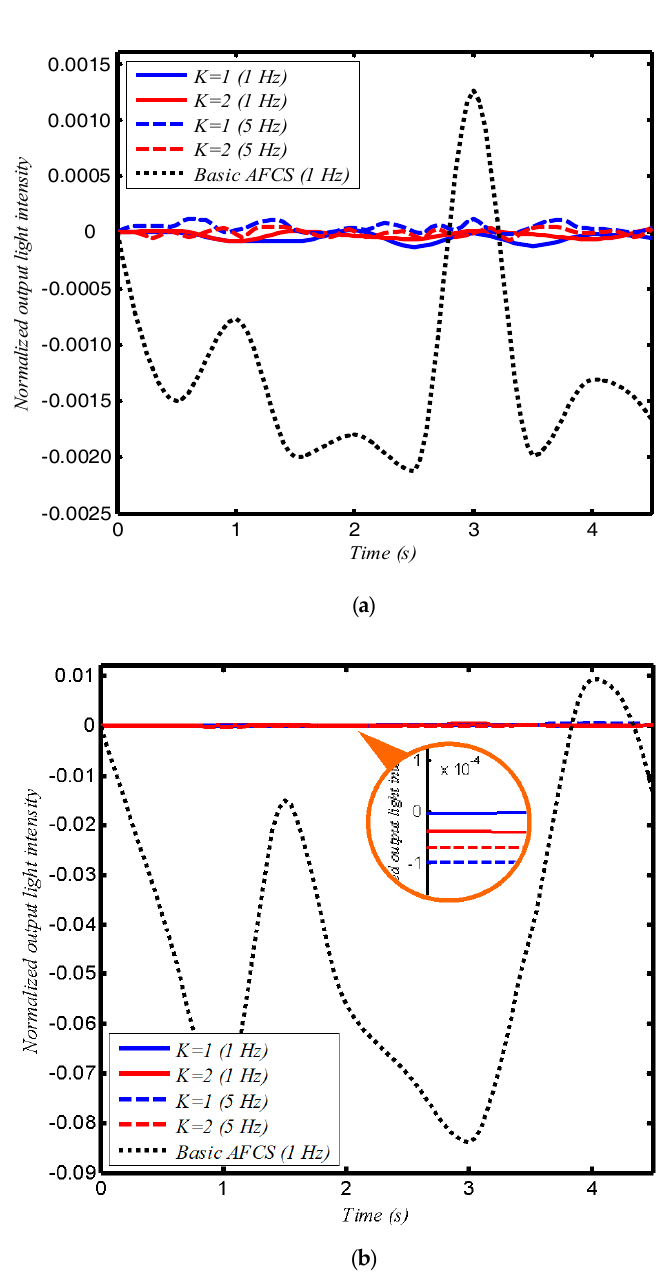
Figure 6. The effect of vibration on the loop AFCS based on the SPSM couplers, ( a ) for 1 mm amplitude, and ( b ) for 10 mm amplitude.